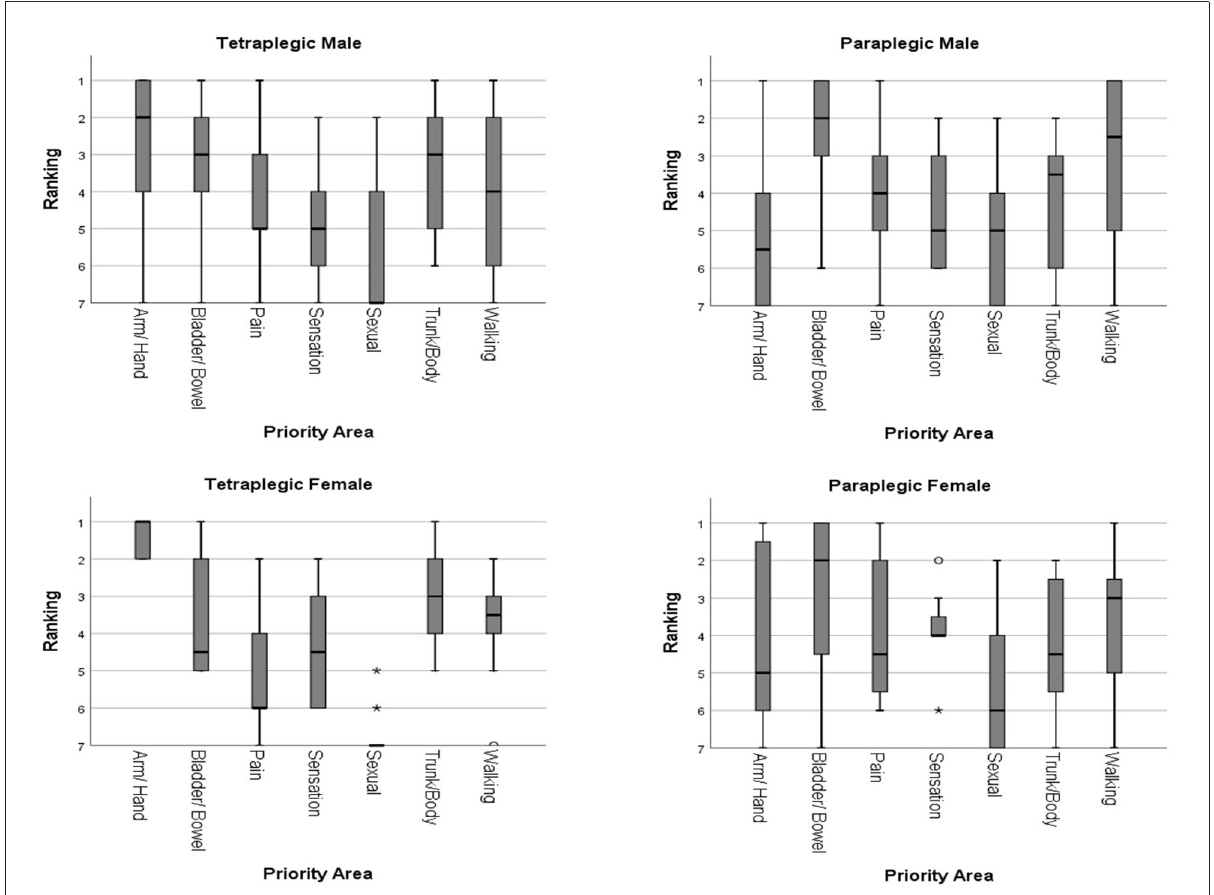
FIGURE2 Rankings of the priority areas of functional recovery according to